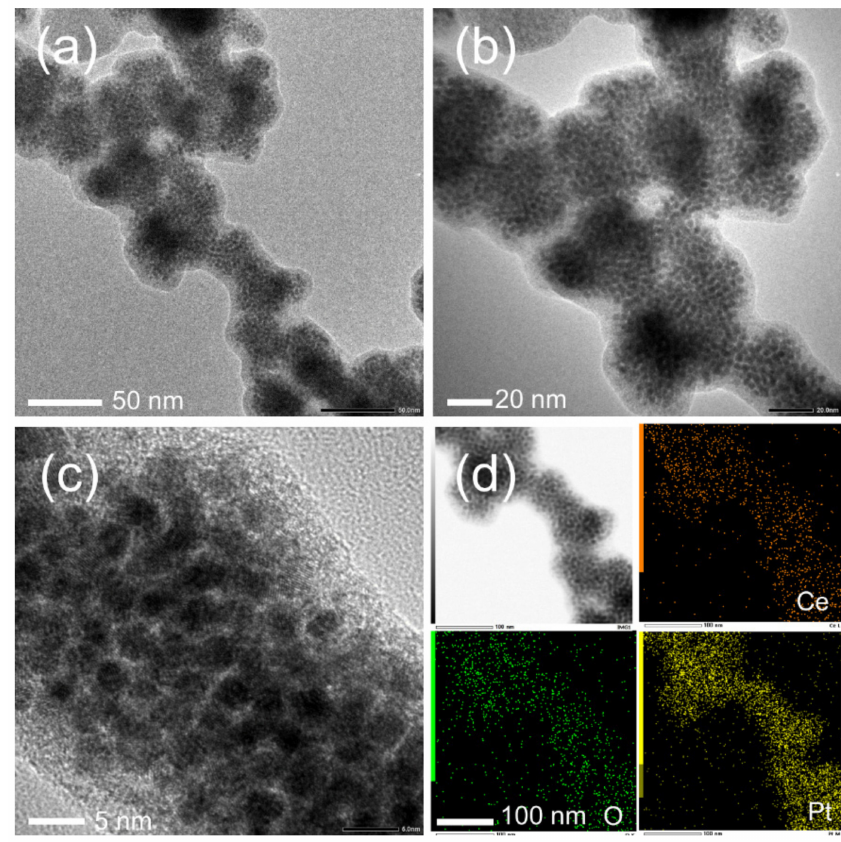
Figure 9. ( a – c ) TEM, and ( d ) EDS element mapping of the Pt/CeO 2